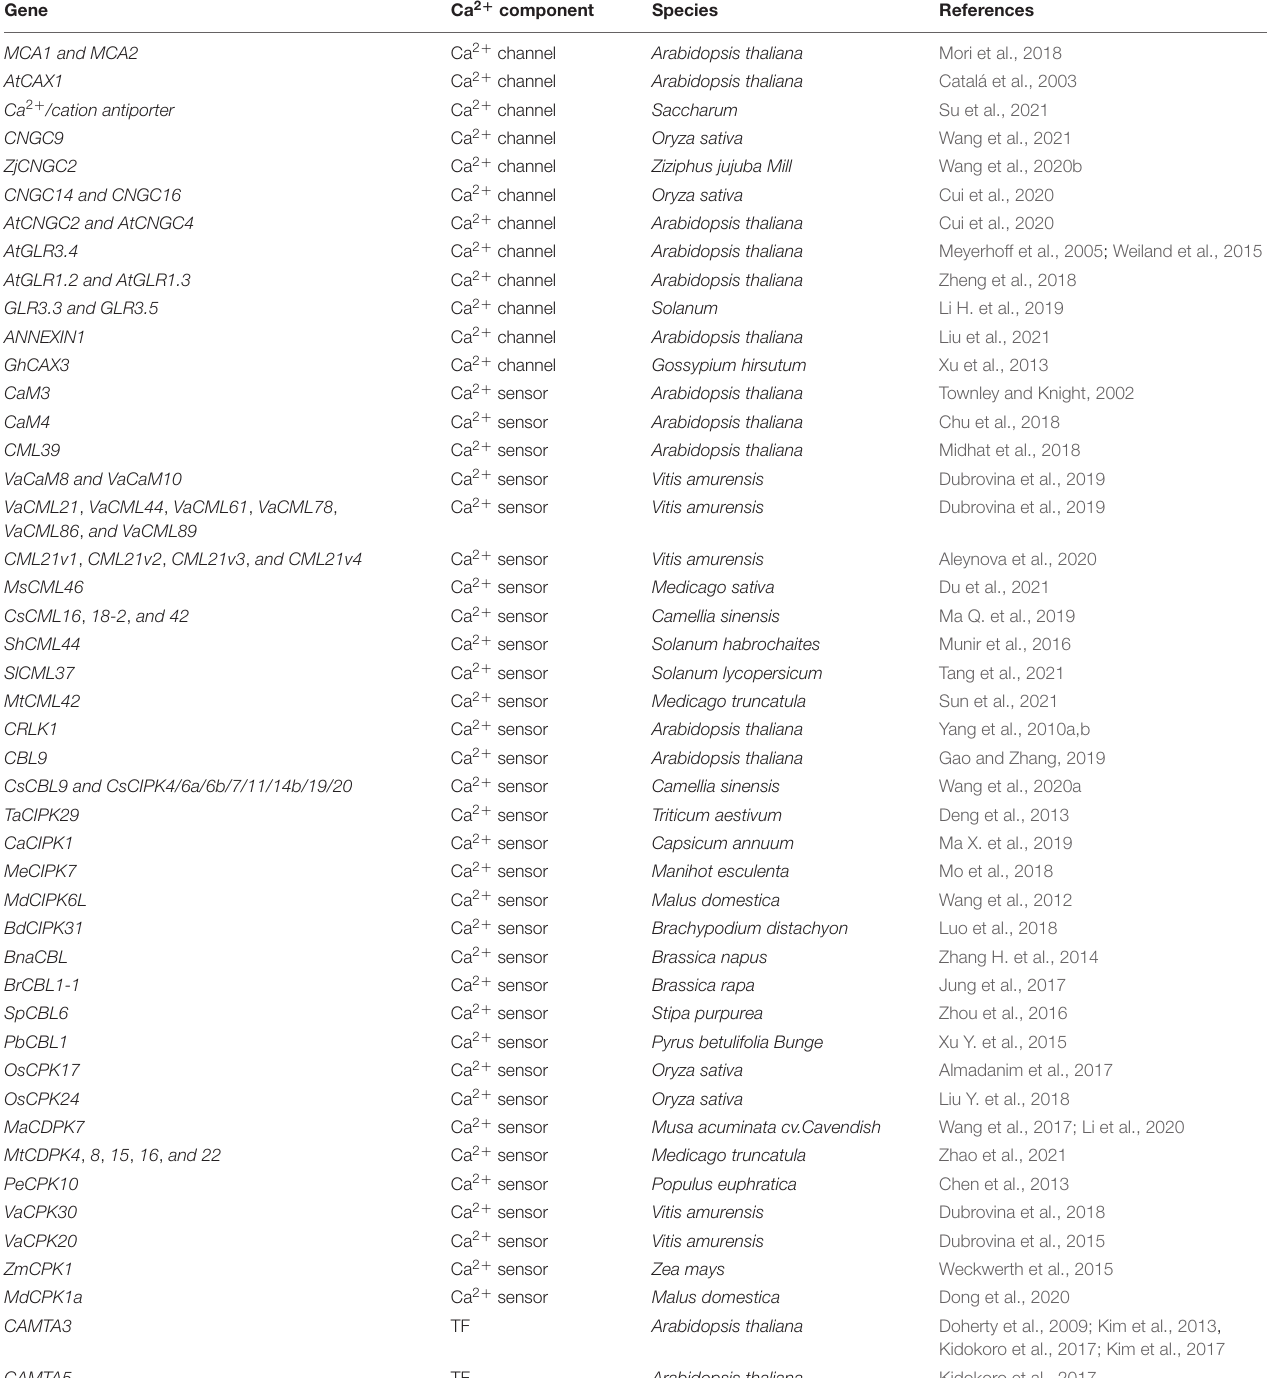
TABLE 1 | Calcium signaling components in cold stress acclimation in plants. Gene Ca 2 + component